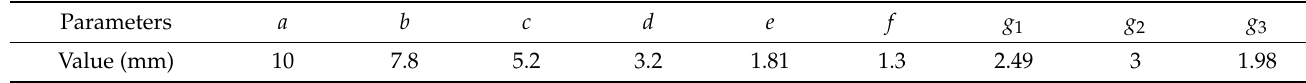
Table 2. Parameters of the MTM unit